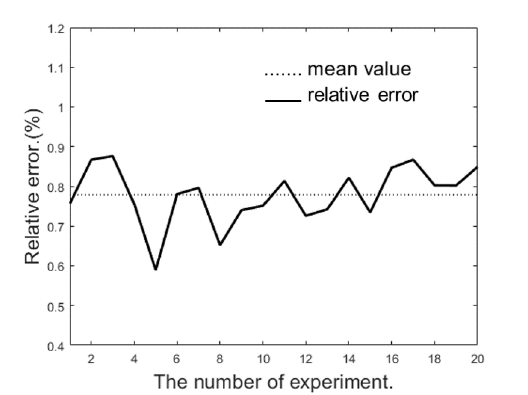
Figure 15. The relative error when input voltage phase is imbalance.